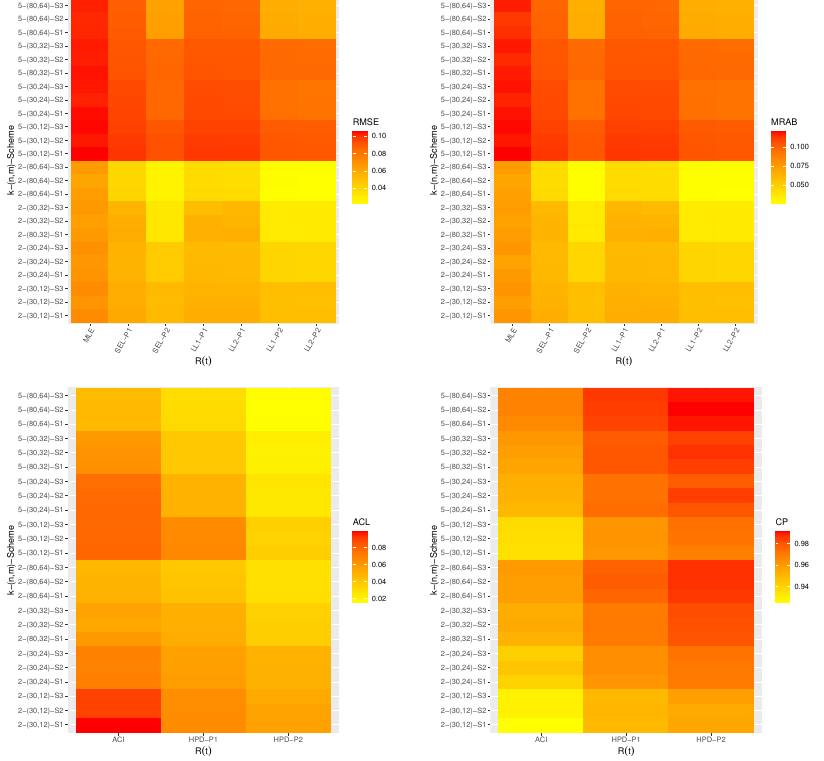
Figure 3. Heatmap plots for classical and Bayesian estimation results of R ( t )